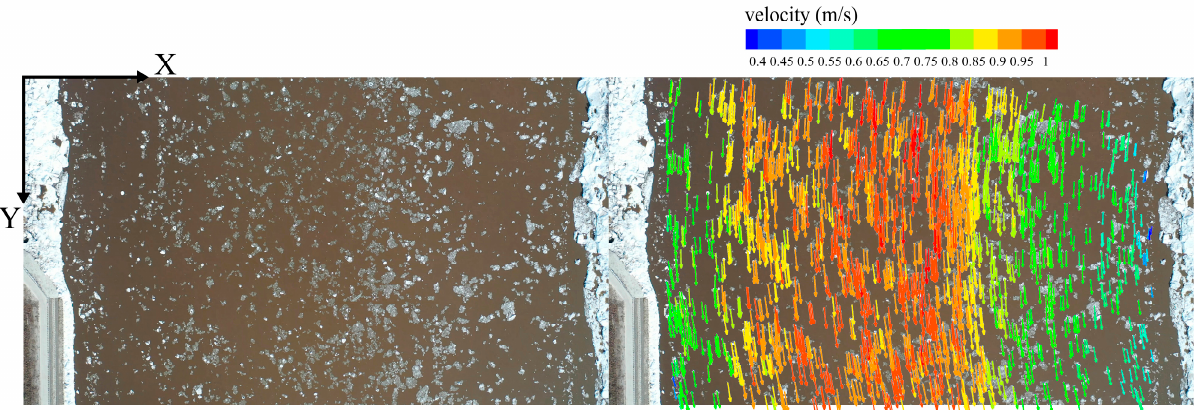
Figure 6. Plane velocity field at 8:00 on 26 April 2021 (define the transverse pixel coordinate as x, and the longitudinal pixel coordinate as y, the coordinate directions are as shown in this figure).